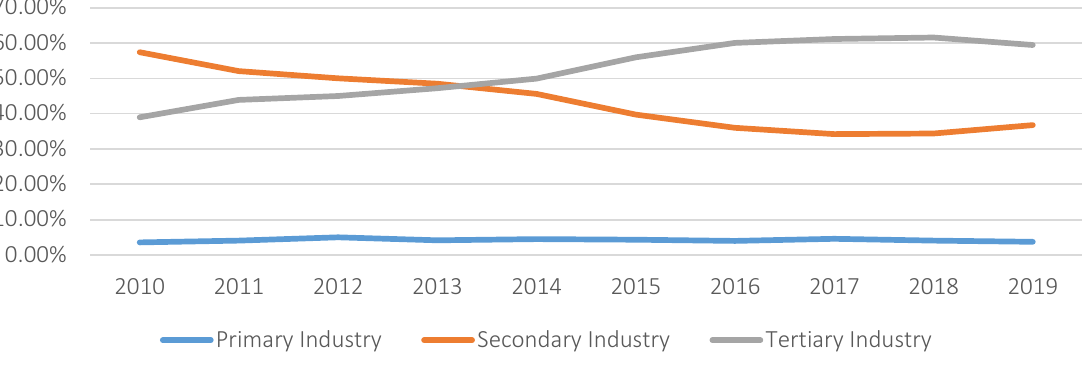
Figure 2. Economic growth contribution rate of China’s three industries (2010–2019)